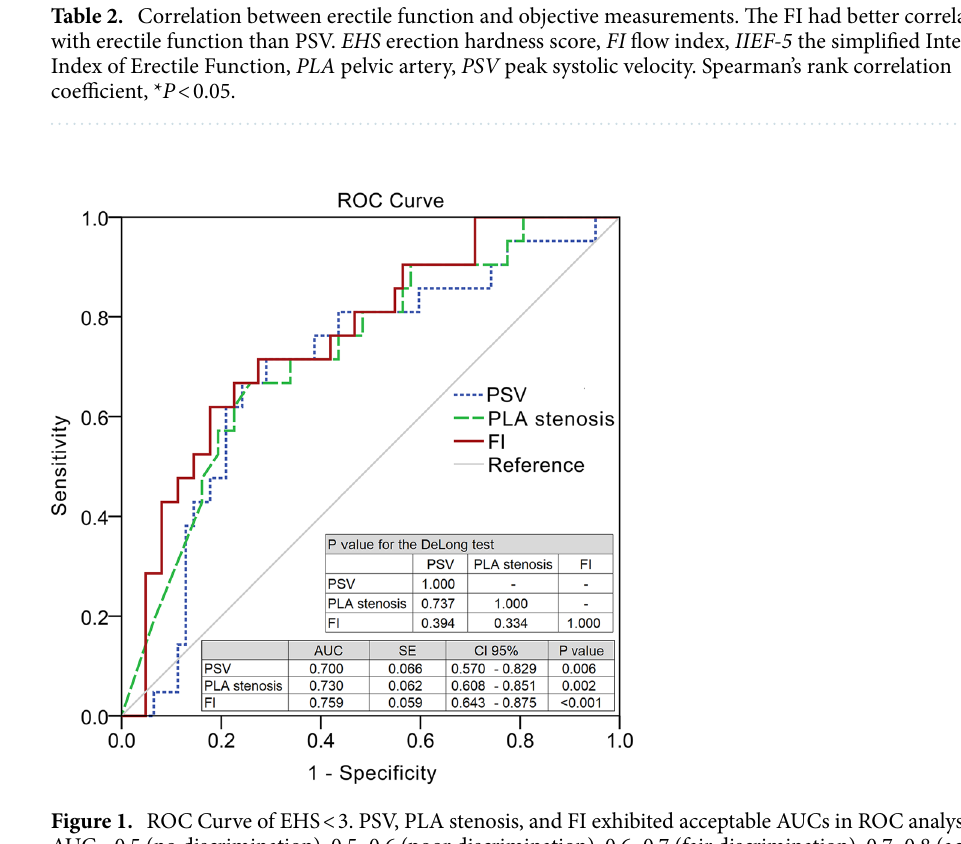
for PLA stenosis and FI) (Fig. 1). The cut-off values identified by the Youden index were 33.97 cm/s, 21.50%, and 52.47 for the PSV, PLA stenosis, and FI, respectively. Patients with EHS < 3 who had normal DUS.